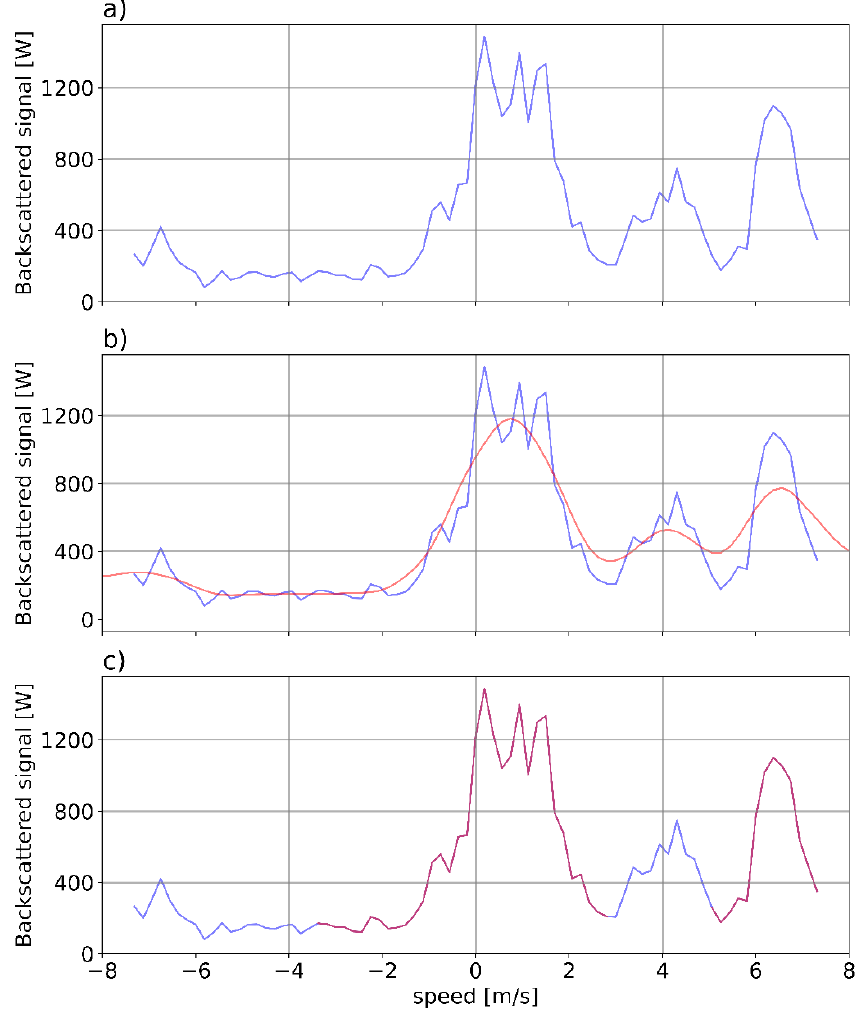
Figure 4. Signal peak detection on a vertical beam: ( a ) original signal, ( b ) convolution (in red) and original signal (in blue) ( c ) result, where part of the original signal was refused (in blue) and the rest (in red) was the corrected signal. At most two peaks were kept from the original signal. Data corresponds to Beam number 1 (vertical incidence, positive values corresponding to downward movement).